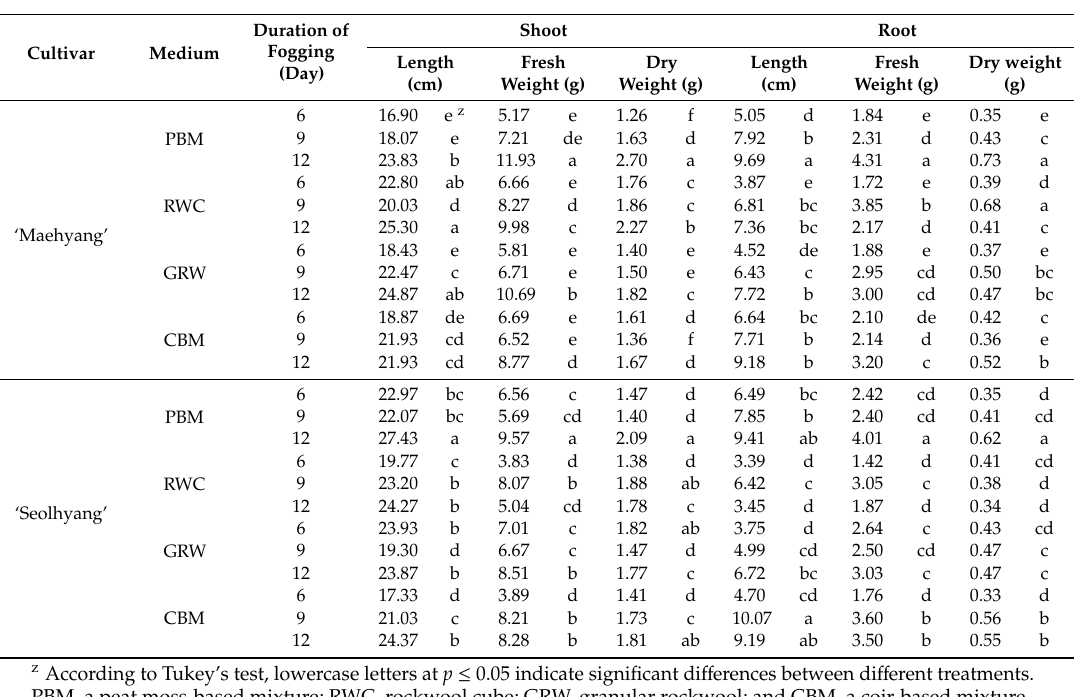
Table 3. The e ff ects of the growth medium, fogging duration and cultivar, on the length, fresh weight and dry weight of the strawberry daughter plants after 15 days.